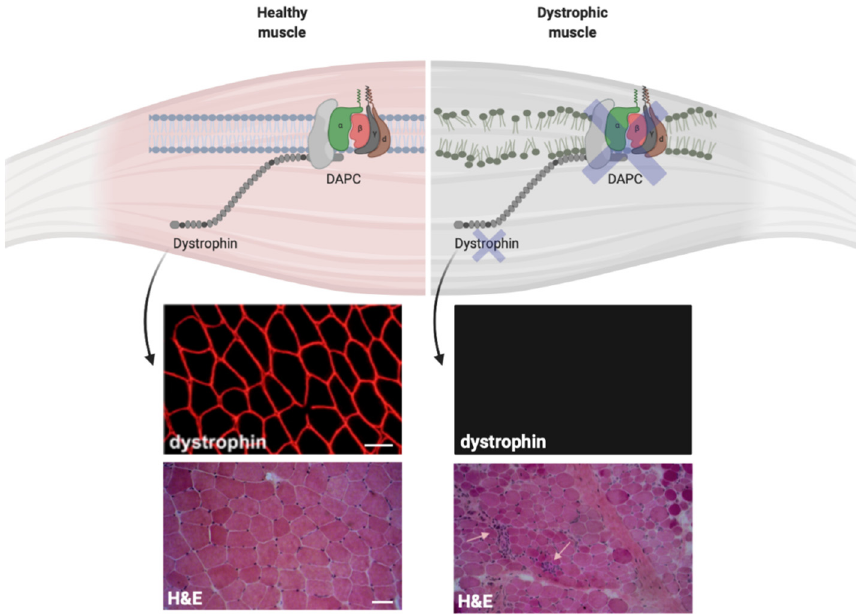
Figure 2. Dystrophin expression influences the plasma membrane stability in muscle cells. Dystrophin expression on the plasma membrane of normal and dystrophic cells. The immunofluorescence stainings for dystrophin show normal dystrophin signal in muscle biopsy collected from healthy control (top left) and the absence of dystrophin in muscle biopsy from Duchenne muscular dystrophy (DMD) patient (top right). The hematoxylin and eosin (H&E) staining show normal muscle architecture in healthy control (bottom left) and tissue architecture disruption in DMD muscle biopsy (bottom right). Small arrows show immune infiltrates within the dystrophic tissue. Scale bars = 50 μ m.